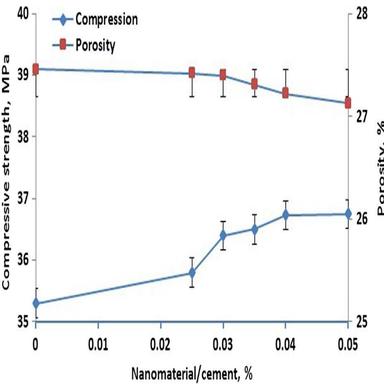
Different ratios of titanate nanofibers mixed with cement for mechanical improvement.